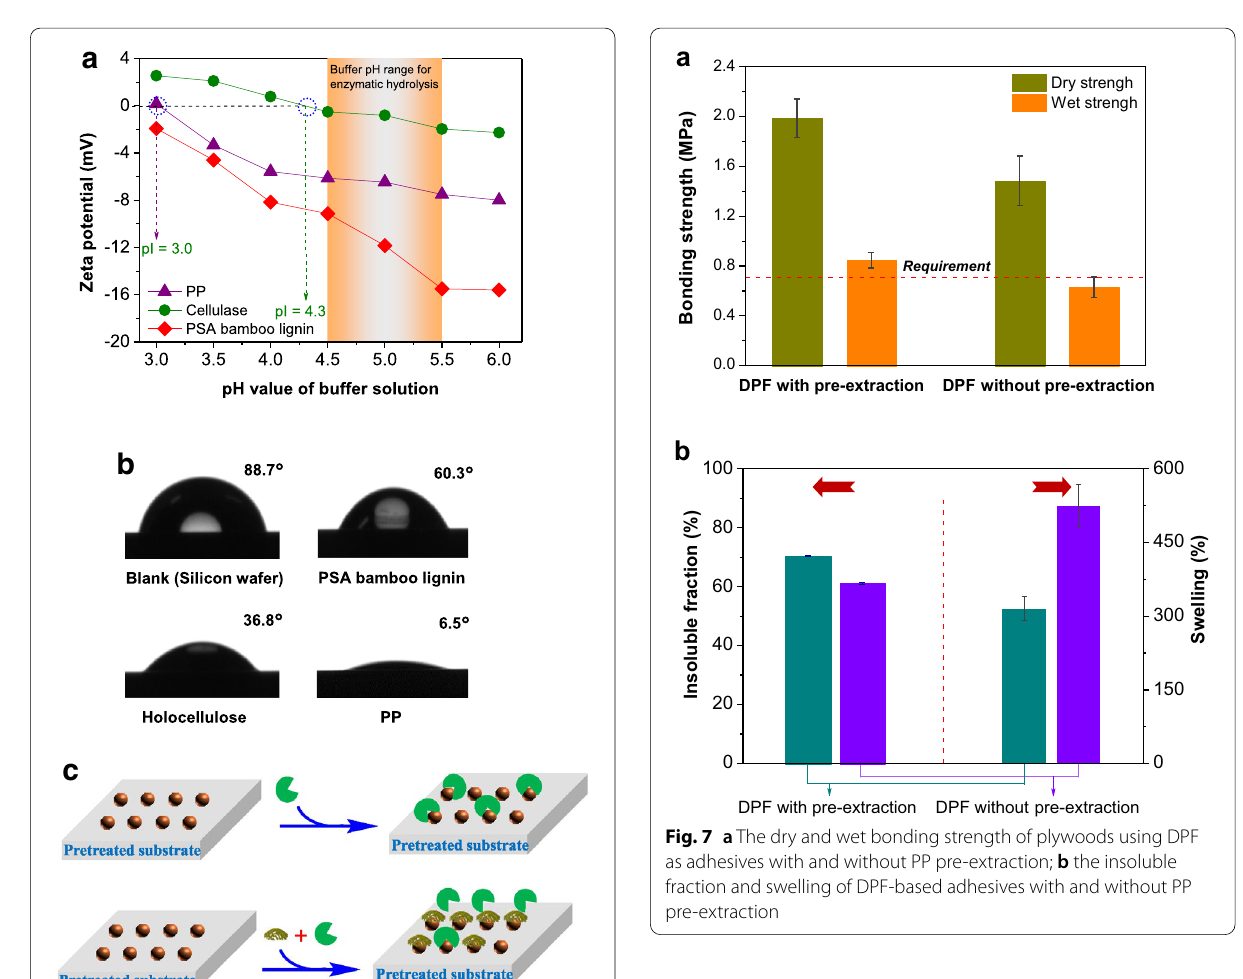
the Chinese National Standard GB/T 9846-2015, resid- ual DPF-based adhesive also resulted in a wet bonding strength of 0.9 MPa that met the requirement of ply- wood for interior applications while only a wet bonding strength of only 0.6 MPa was obtained for the DPF-based adhesive (Fig. 7a). The insoluble fraction and swelling of residual DPF-based adhesive were lower than those of DPF-based adhesive (Fig. 7b and Additional file 1: Figure S5). We thereby speculate that the better performance of residual DPF-based adhesive should be attributed to the removal of low-molecular-weight and water-soluble pro- teins (that is PP in the context) (Chen et al. 2015), which would lead to more compact crosslinking structure and higher water resistance of residual DPF-based adhesive. In order to verify this speculation, the molecular weight of PP extracted by acetate buffer was characterized by SDS-PAGE. The SDS-PAGE measurements of peanut protein isolate (PPI) extracted by a traditional alkali dissolution method and BSA were also used for com- parison. SDS-PAGE results showed that the molecular weight (MW) distribution of the proteins in PPI included